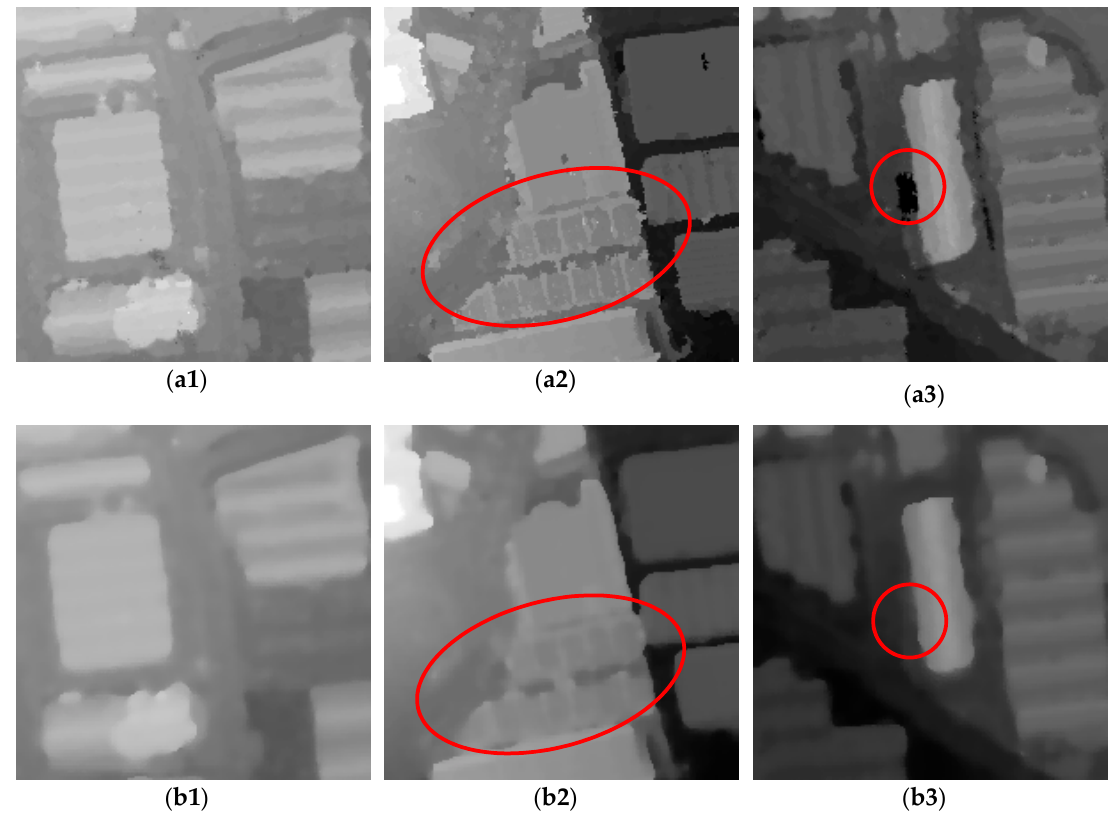
Figure 15. Comparison results of DSMs created with IDW and mesh. ( a1 ) building boundary of the IDW-based DSM, ( b1 ) building boundary of the mesh-based DSM, ( a2 ) separated boundaries of buildings of the IDW-based DSM, ( b2 ) blurry boundaries of buildings of the mesh-based DSM, ( a3 ) noise of the IDW-based DSM, ( b3 ) interpolated surface of the mesh-based DSM.